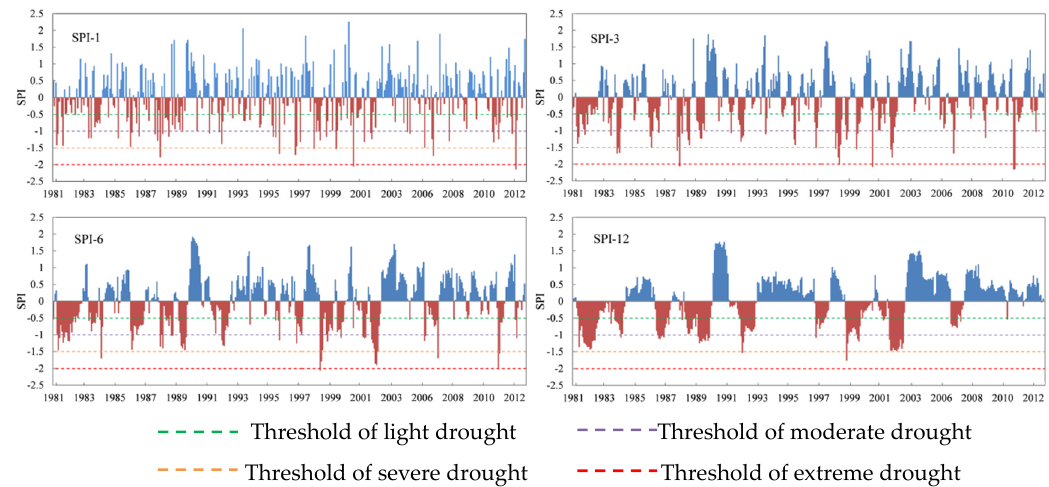
Figure 2. Standard Precipitation Index (SPI) at 1-, 3-, 6-, and 12-month scales during 1981–2012 in Shandong Province. Blue indicates wetness, and red indicates drought. Table 2. Summary of drought events in Shandong Province from 1981 to 2012.